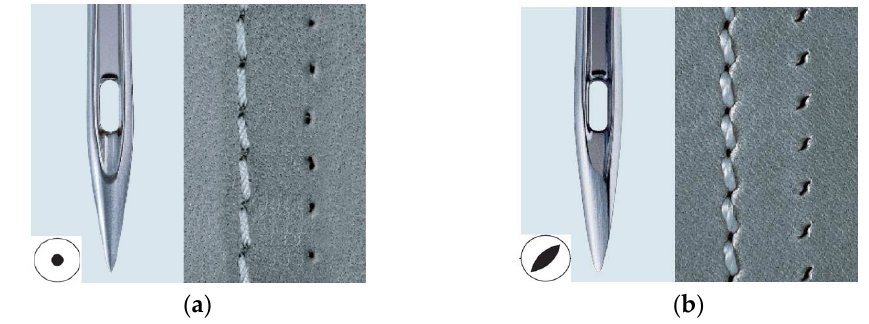
Figure 2. ( a ) tip of the needle R, ( b ) tip of the needle LR.